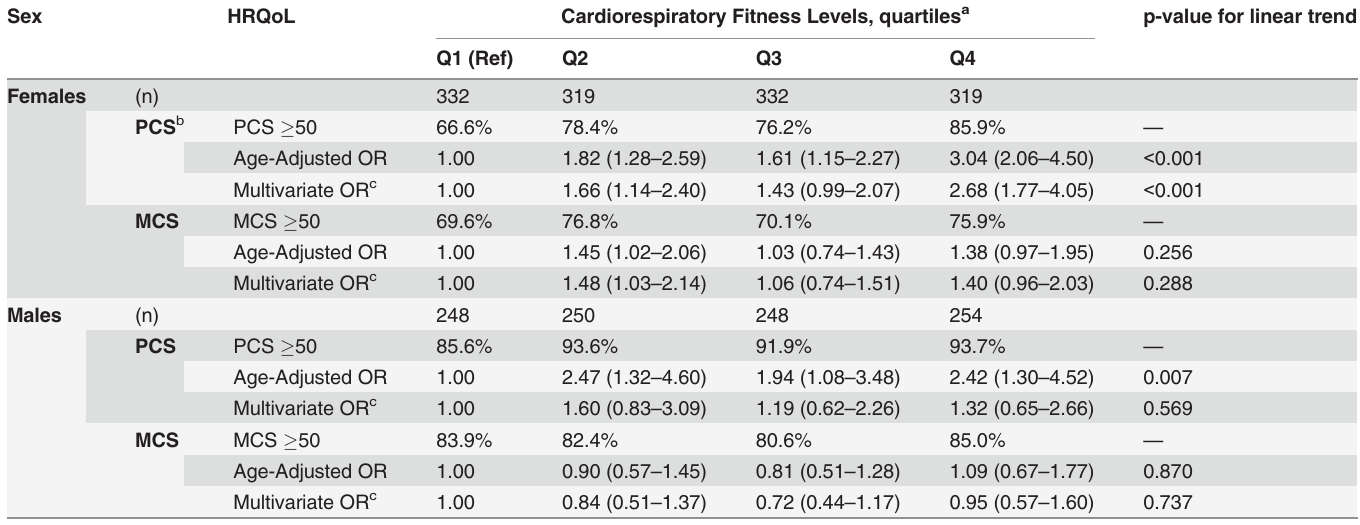
Table 3. Odds ratios (ORs) above the norm for PCS and MCS according to cardiorespiratory fitness